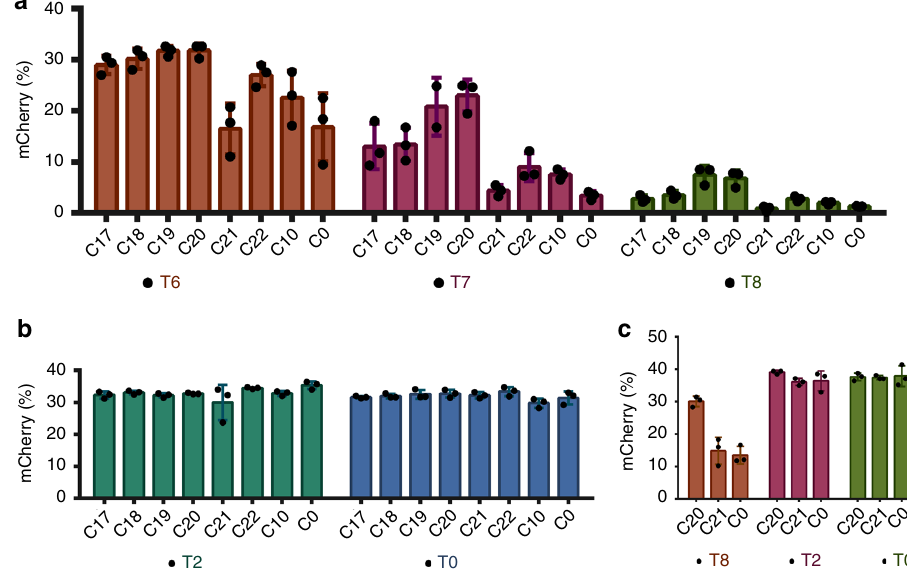
Fig. 3 Cas9 tolerates heavily and fully modi fi ed crRNA:tracrRNA. a , b Each crRNA was tested with tracrRNAs T0 , T2 , and T6 – T8 using 20 pmol of Cas9 RNP. c HEK293T-TLR cells were also electroporated with 100 pmol of the indicated RNPs to test whether heavily modi fi ed RNAs regain functionality at higher doses. Error bars show± SD of three biological